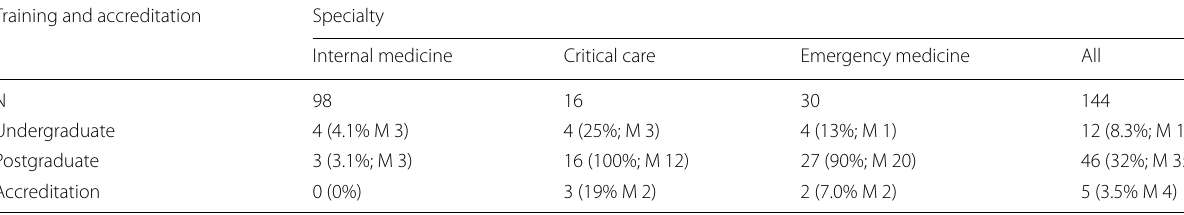
Data are stratified by specialty. Data are presented as frequency and percentage. Data for internal medicine stratified by postgraduate year of training and gender are presented in Additional file 2: Appendix 2: Table 6. N number of respondents, M male, PGY postgraduate year of training, POCUS point-of-care ultrasound